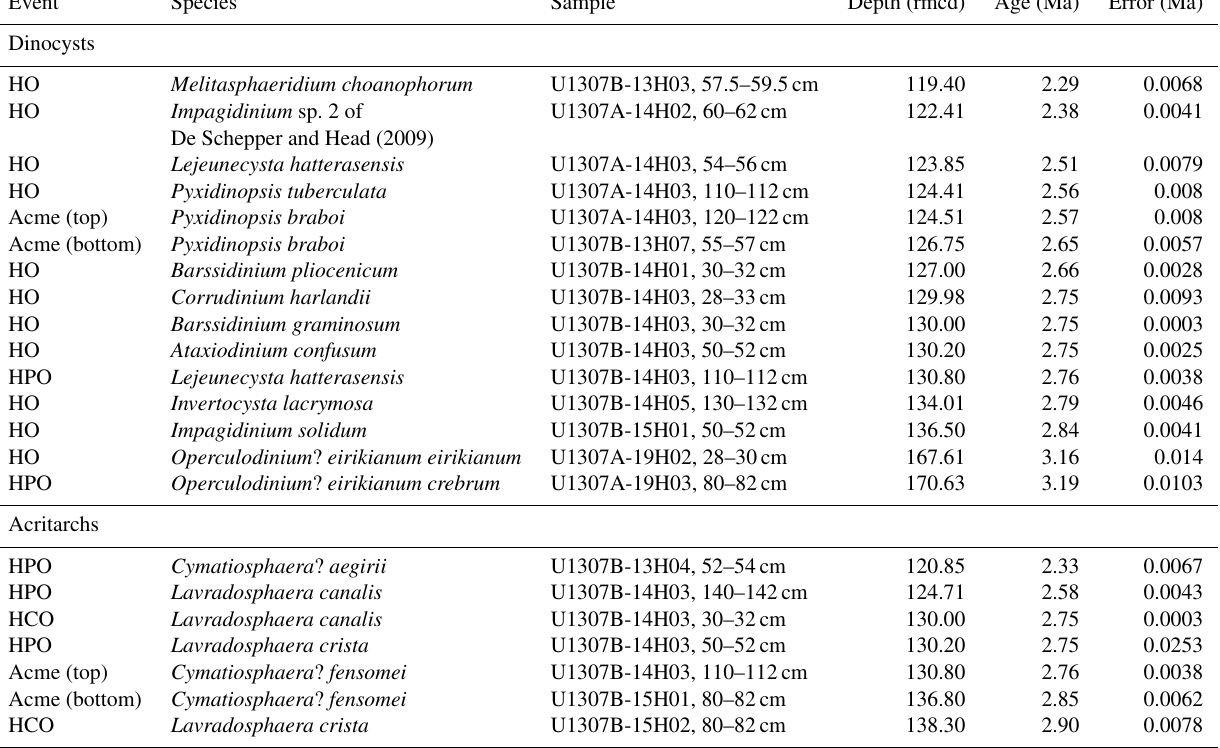
Table 2. Dinocyst and acritarch bioevents at IODP Site U1307. The age model error is from Blake-Mizen et al. (2019) and the age error is based on the sampling interval. HO: highest occurrence; HCO: highest common occurrence; HPO: highest persistent